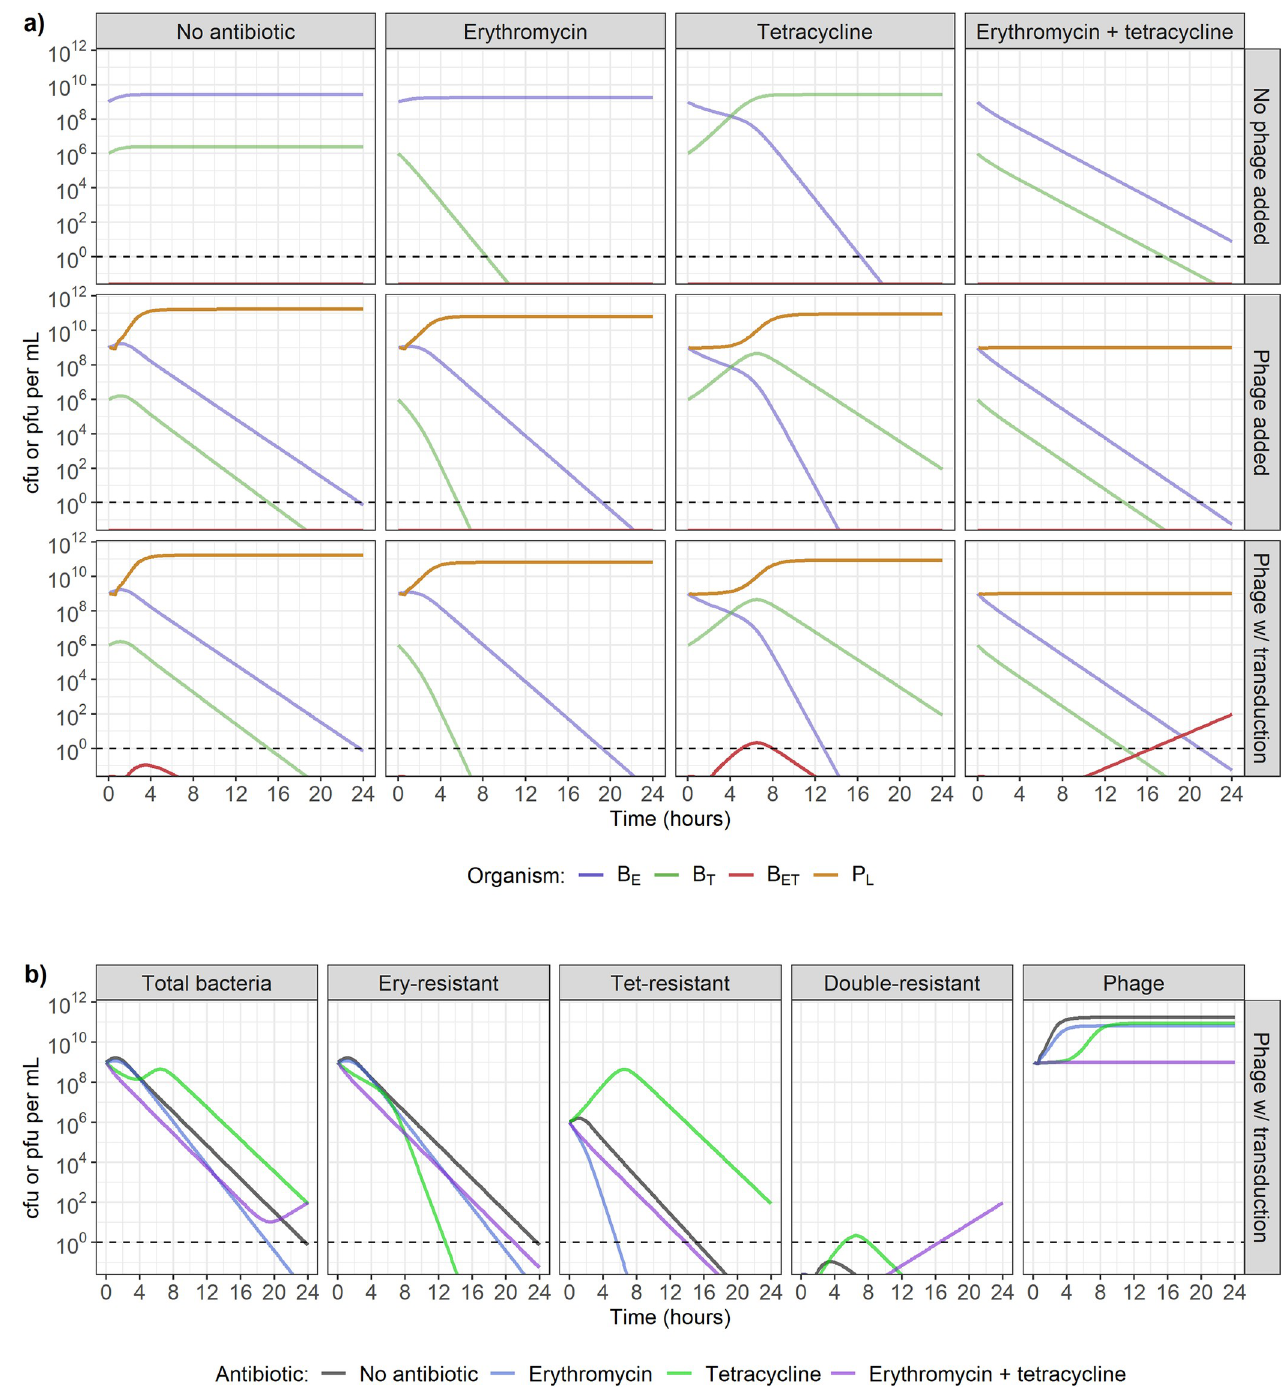
Fig 4. a) Model-predicted dynamics with one single-resistant strains starting at carrying capacity (10 9 colony-forming units (cfu)/mL) and the second in minority (10 6 cfu/mL), in the presence of no antibiotics (1st column), erythromycin only (2nd column), tetracycline only (3rd column), or both erythromycin and tetracycline (4th column), combined with either no phage (top row), phage incapable of transduction (middle row), or phage capable of generalised transduction (bottom row). Erythromycin-resistant bacteria (B E ) are initially present at a concentration of 10 9 cfu/mL, and tetracycline- resistant bacteria (B T ) at 10 6 cfu/mL. Antibiotics and/or phage (P L ) are present at the start of the simulation, at concentrations of 1 mg/L (4 x MIC for susceptible strains) and 10 9 plaque-forming units (pfu)/mL respectively. Double-resistant bacteria (B ET ) can initially be generated by generalised transduction only, and then by replication of existing B ET . Dashed line indicates the detection threshold of 1 cfu or pfu/mL. b) Change in bacteria (single-resistant to erythromycin, single-resistant to tetracycline, or double-resistant) and phage numbers depending on the antibiotic exposure, in the presence of phage capable of generalised transduction. Dashed line indicates the detection threshold of 1 cfu or